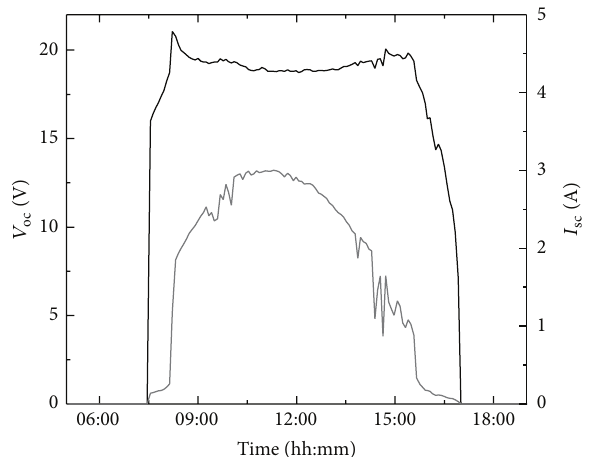
Figure 5: Individual panel short-circuit current (grey solid line) and open-circuit voltage (black solid line) against the time during the whole